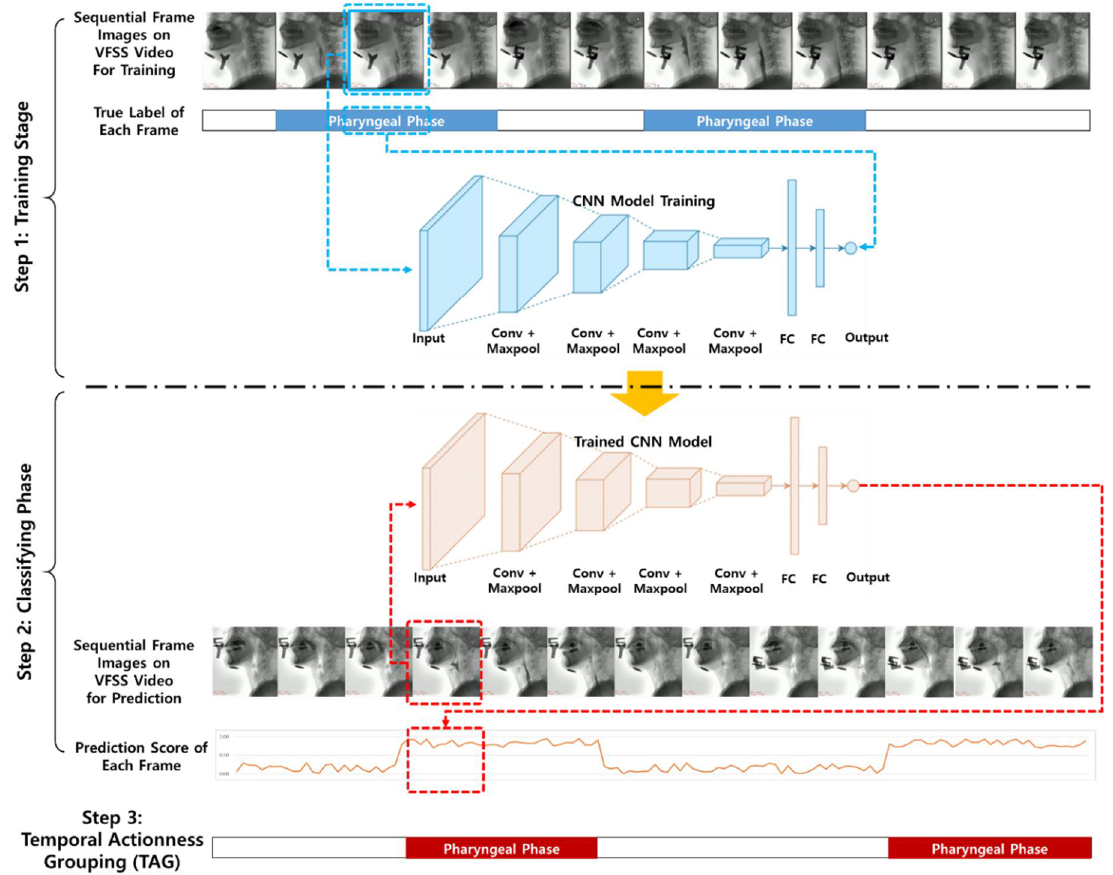
Figure 2. Conceptual diagram of framework proposed herein.